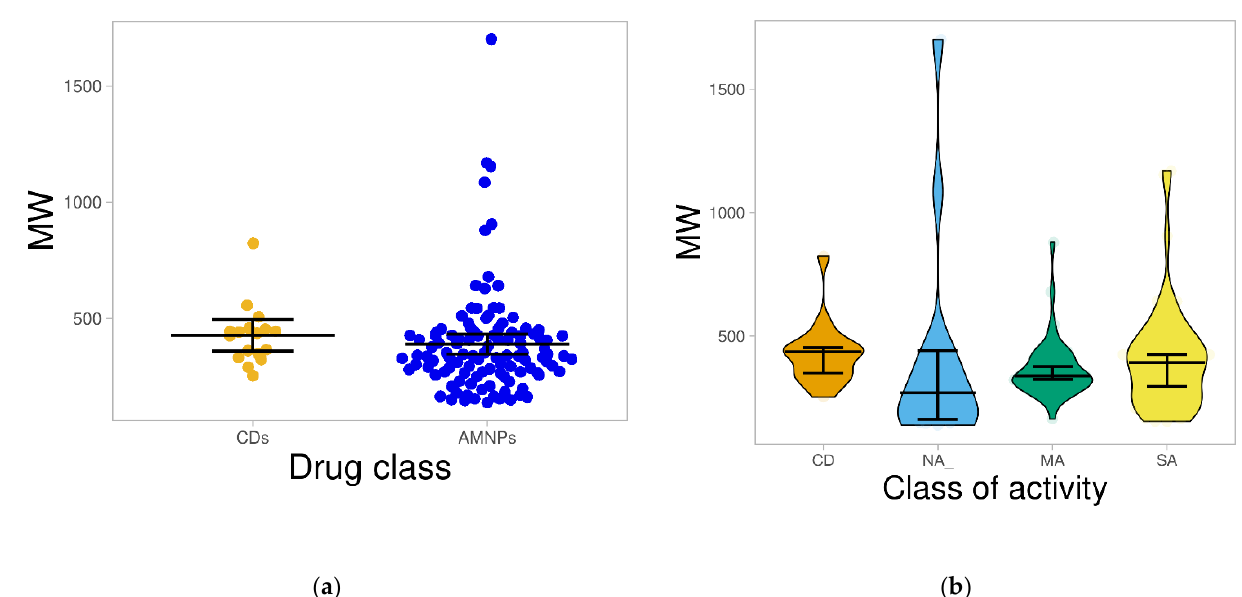
Figure 1. Distribution of the molecular weight of the datasets. ( a ) presents the distribution of AMNPs and CDs on a plot. The line that divides the plots denotes the mean of the distribution, which shows no statistical difference ( p > 0.05) between the CDs and AMNPs. ( b ) shows the violin plot of the CDs compared with the various categories of the AMNPs. The boxes indicate the distribution of each of the datasets; the line that divides each of the boxes represents the median of the distributions. The black bars in both figures indicate a 95% confidence interval.